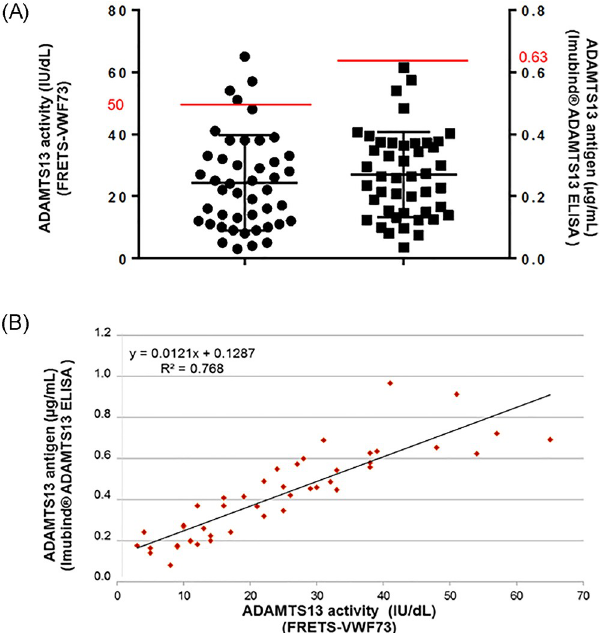
Fig 2. Investigation for ADAMTS13 in 45 patients with HLH. (A) Each patient is represented by an icon; ADAMTS13 activity and ADAMTS13 antigen levels are represented in the same graph; the upper limit of normal ranges are represented as red lines; medians and IQR are represented as black lines. (B) Correlation curve between ADAMTS13 activity and ADAMTS13 antigen.